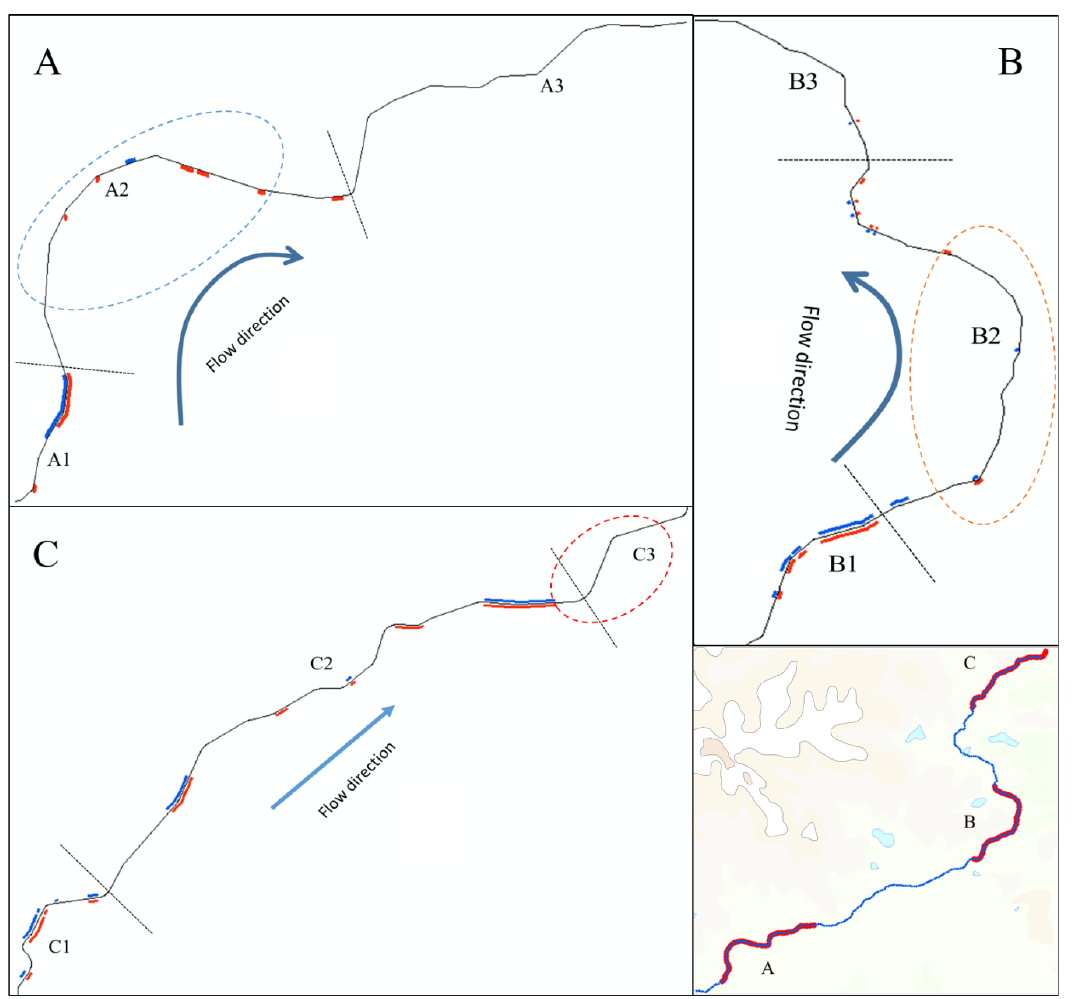
Figure 7. Distribution of algae growth zones.